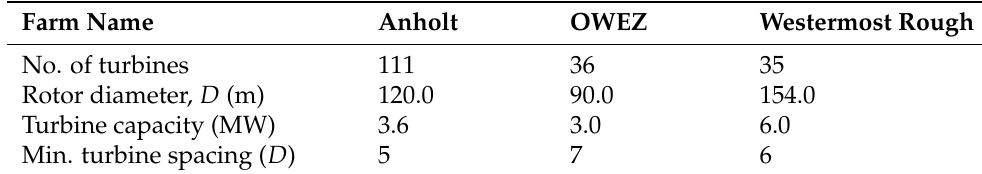
Table 1. Essential information for the three offshore wind farms.